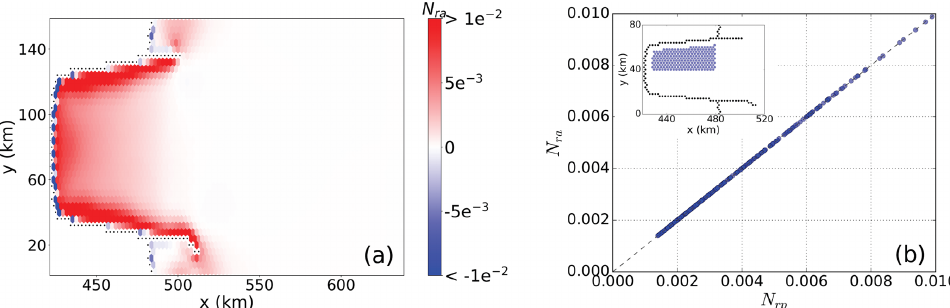
Figure 11. (a) Grounding-line flux sensitivity for the MISMIP + domain derived from the adjoint model approach. (b) Perturbation- ( N rp ; x axis) versus adjoint-based ( N ra ; y axis) sensitivities plotted against one another (perturbation locations are shown by circles in the inset, where the grounding-line grid cells are shown by the black dots.)